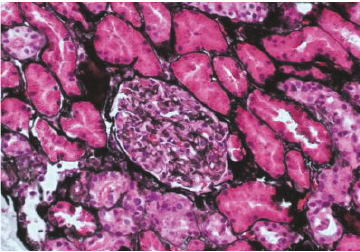
Figure 2: PAS stain. PAS stain showing tubular atrophy, glomeruli congestion, and normal capillary loops in the glomerulus.